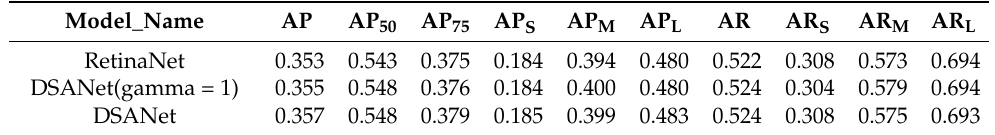
Table 4. Comparison of DSA module with different gamma setting. DSANet(gamma=1) represents the value of parameter gamma in Equation (2) is set to 1.